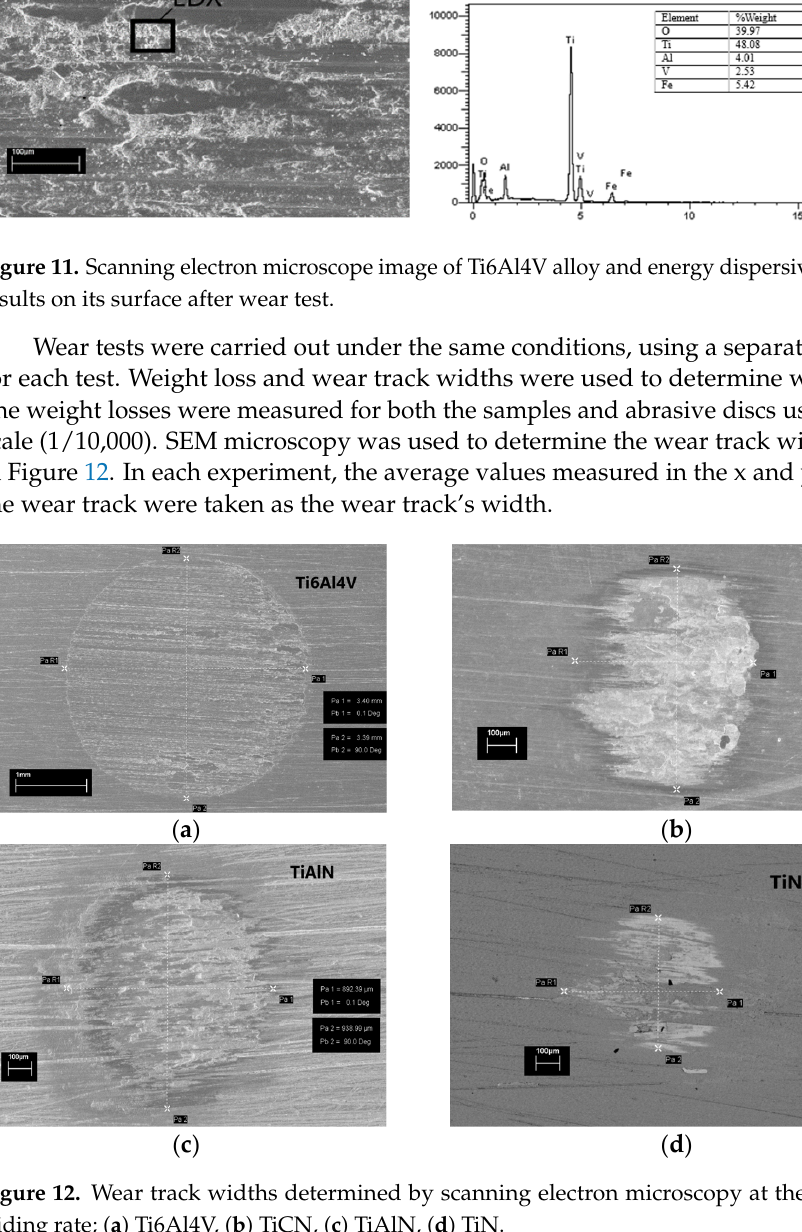
Figure 10. The variation in coefficient of friction with surface roughness. ( a ) 0.5 m/s sliding rate, ( b ) 0.9 m/s sliding rate.